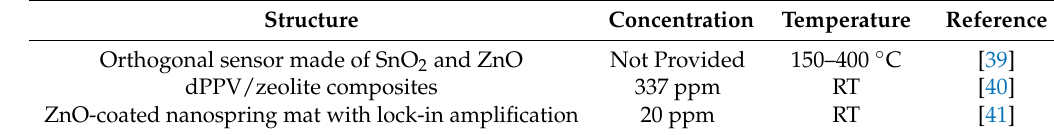
Table 1. Studies on AN detection through electrical